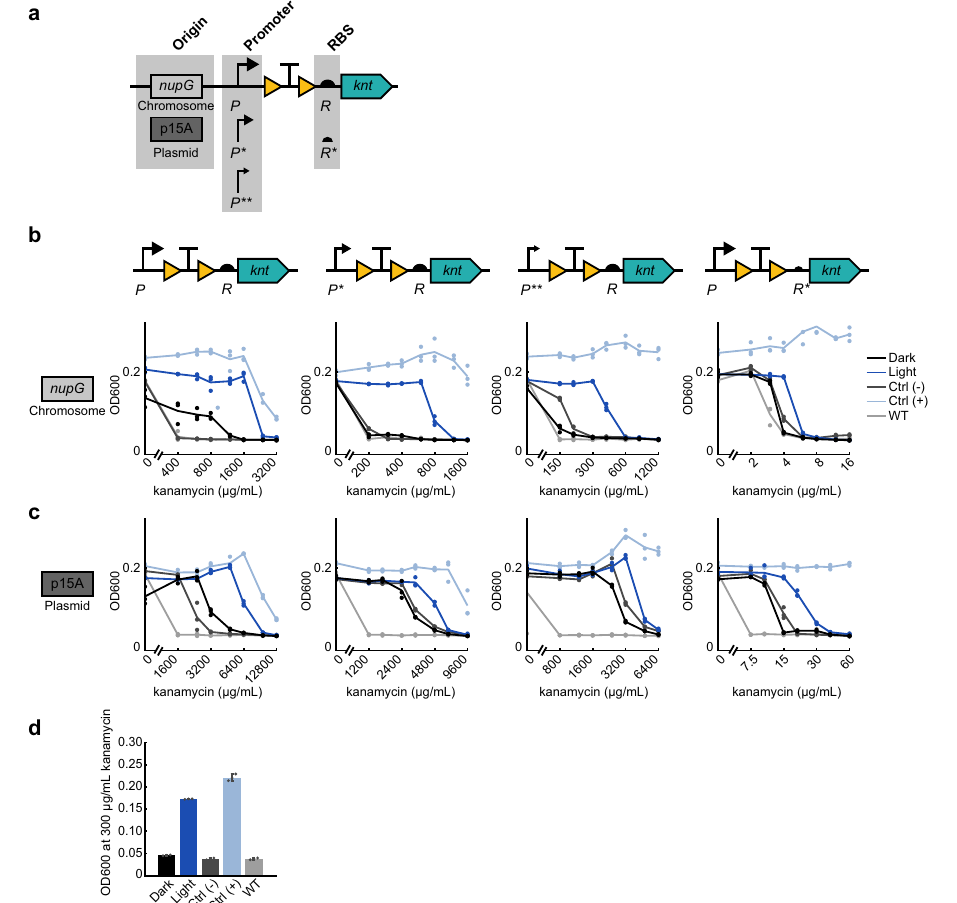
Fig. 2 | Optimizing optogenetic activation of kanamycin resistance from OptoCre- knt by modifying promoter and ribosome binding site (RBS). a Expressionlevelsof thekanamycinresistancegene knt canbetunedbychanging thestrengthofthepromoterandRBS,aswellastheoriginofreplication.Promoter strength ranges from P (medium) to P* (medium-low) to P** (low). RBS strength ranges from R (strong) to R* (weak). b MIC curves of OptoCre- knt activation